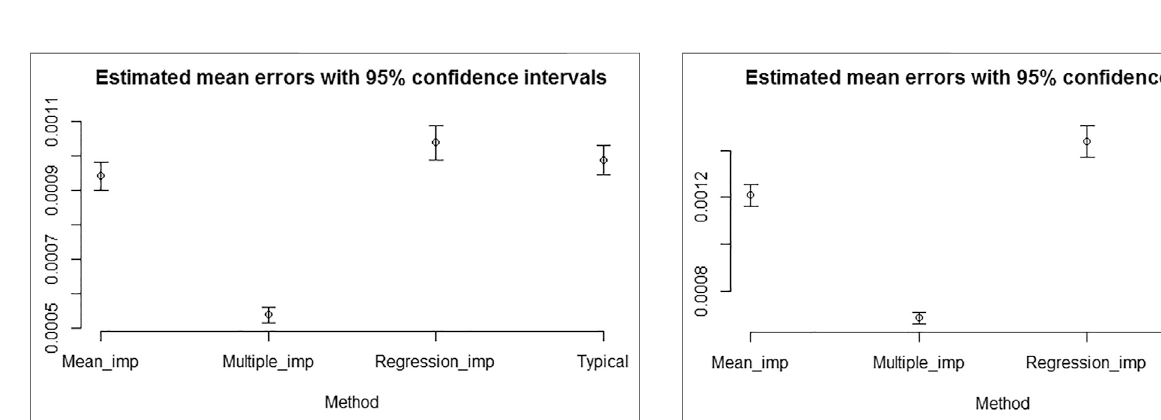
FIGURE 2 | The scatter plots of Brier scores and standard error estimates from typical and Mixed_q model based computations.